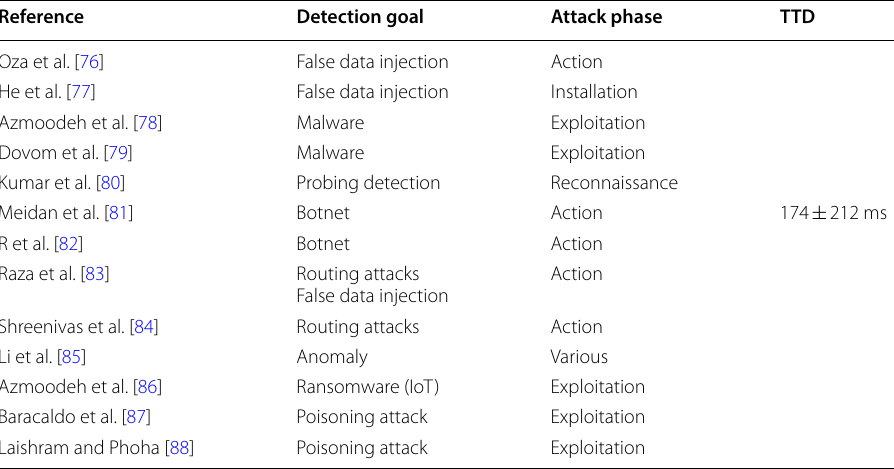
Table 8 Attack details provided by the detection